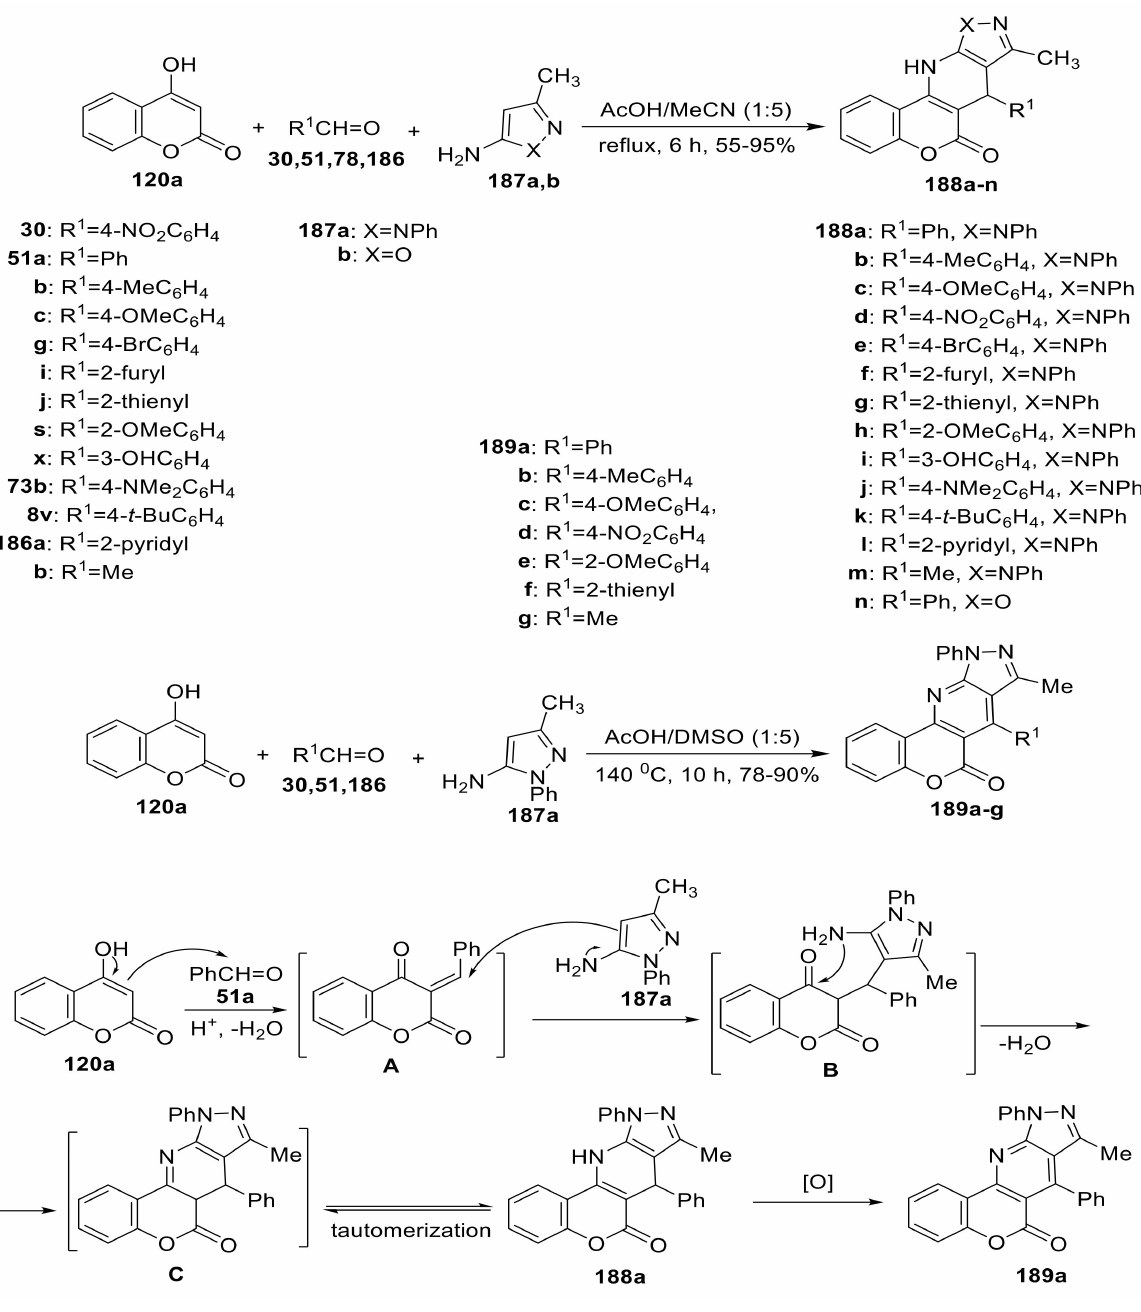
Scheme 51. Three-component synthesis of chromeno [4,3- b ]pyrazolo [4,3- e ]pyridines 189a – g . The same year, Foroumadi and coworkers synthesized the coumarin-fused dihydropy- ridinones 192a – i via a multi-component reaction of 4-hydroxycoumarin ( 120a ), ammonia, aromatic aldehydes, and Meldrum’s acid ( 90e ) in refluxing propan-1-ol [139]. In the proposed mechanism, the benzylidene intermediate A was formed by the Knoevenagel reaction of Meldrum’s acid ( 90e ) with aldehyde 51a (Scheme 54). The amination reaction of 4-hydroxycoumarin with ammonia generated the 4-aminocoumarin ( 13 ), which by a Michael reaction to A led to the intermediate B . Intramolecular cyclization of the latter under loss of acetone and CO 2 resulted in the final product 192a